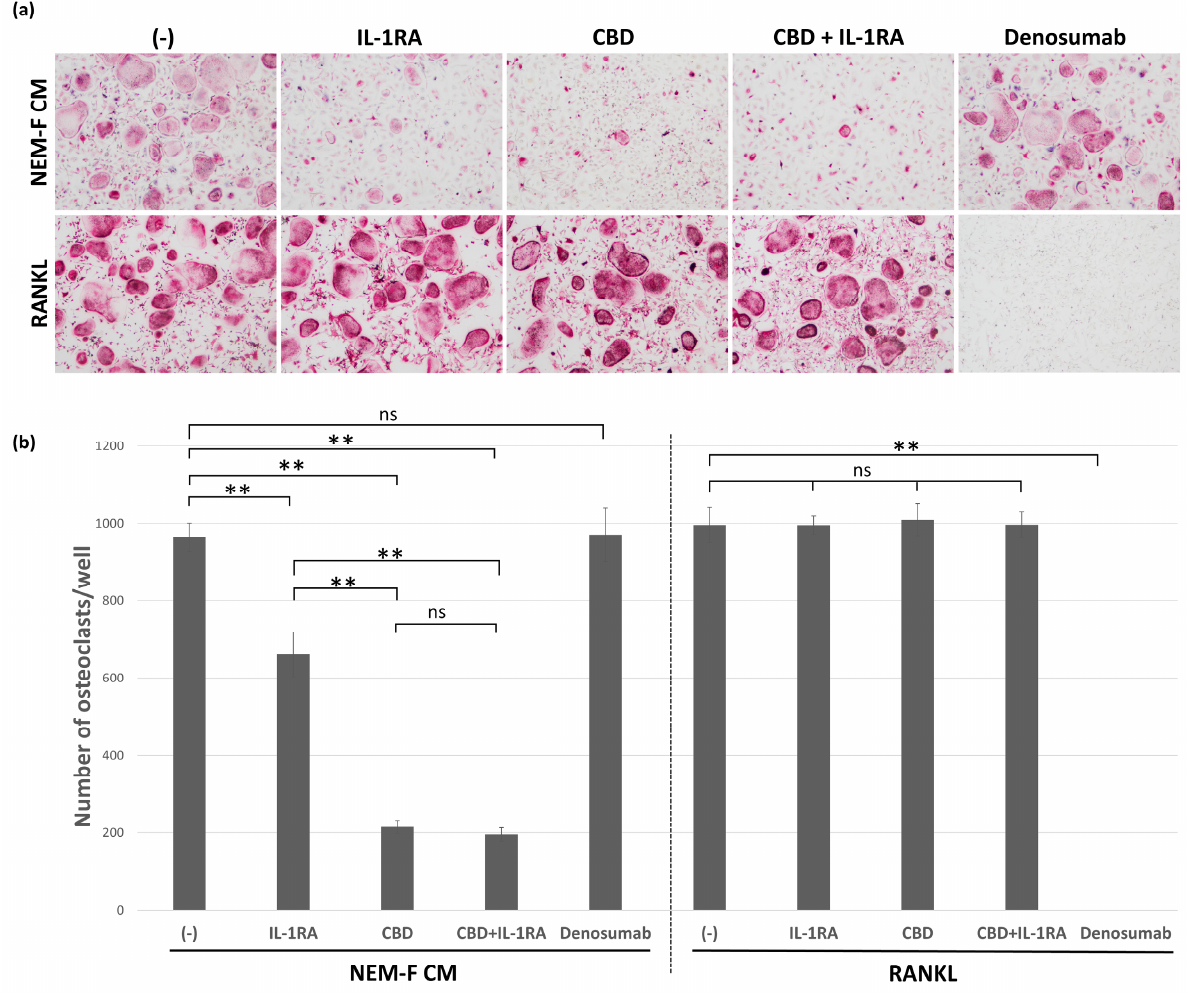
Figure 4. The effects of IL-1RA and CBD on osteoclastogenesis induced by the culture supernatant of NEM-F cells and RANKL. ( a ) Evaluation of IL-1RA, CBD, and denosumab on osteoclastogenesis induced by the culture supernatant of NEM-F cells and RANKL. Representative views of TRAP staining after 5 days of culture. ( b ) The number of osteoclasts induced by the culture supernatant of NEM-F cells and RANKL, with or without treatment of IL-1RA, CBD, and denosumab. ** p < 0.01, ns: not significant (one-way ANOVA with the Tukey–Kramer method).